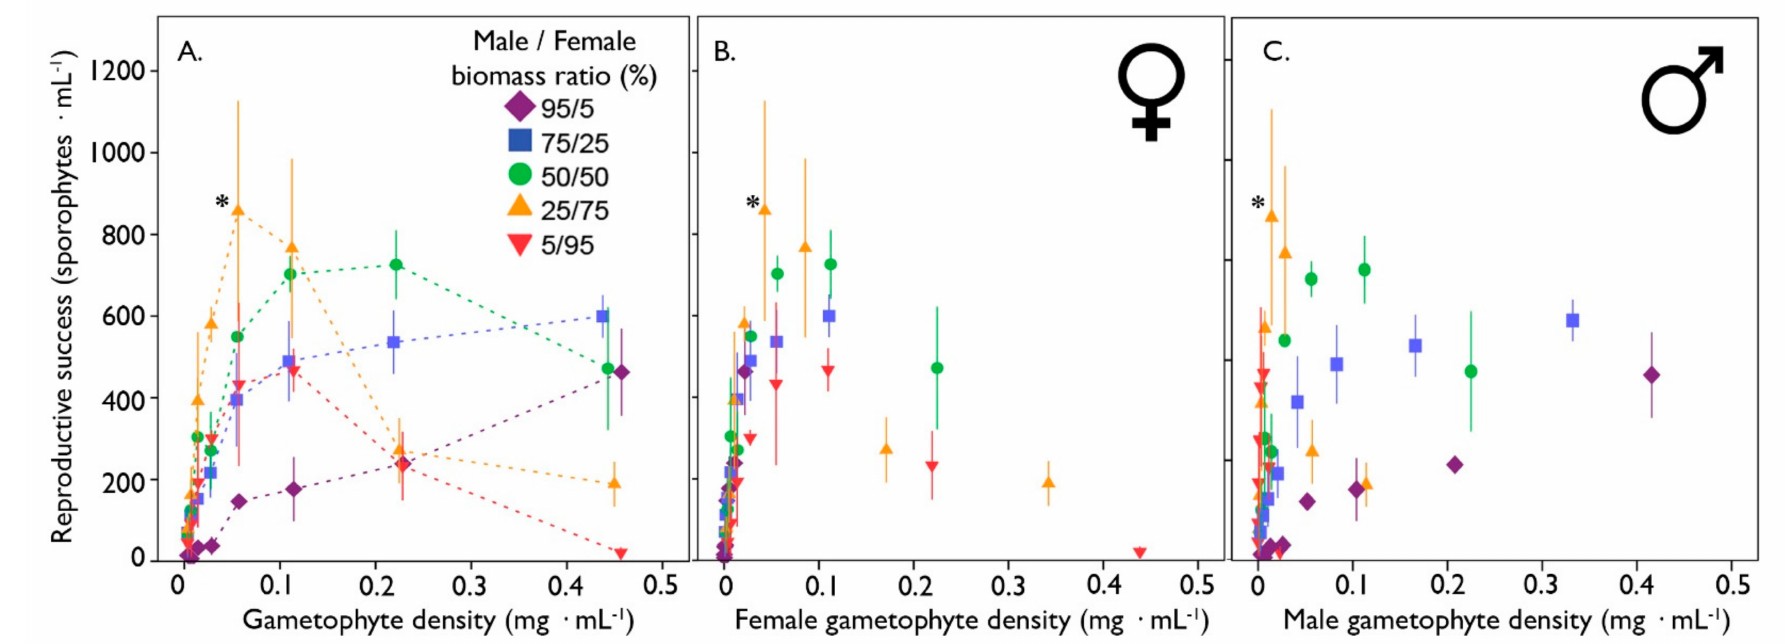
Figure 3. ( A – C ) The influence of the gametophyte density of both sexes (x-axis a ; mg · mL − 1 ), the initial female gametophyte density (x-axis b ; mg · mL − 1 ) and the initial male gametophyte density (x-axis c ; mg · mL − 1 ) on the reproductive success (y-axis; sporophytes · mL − 1 ) of A. esculenta gametophytes. The male:female ratios are described in the figure and symbols of these gradients are depicted in all three figures to allow for comparisons. The (*) is added to visually elaborate how the female gametophyte density ( B ) and male gametophyte density ( C ) are added up to form gametophyte density ( A ). Values are expressed as mean ± SD, n =